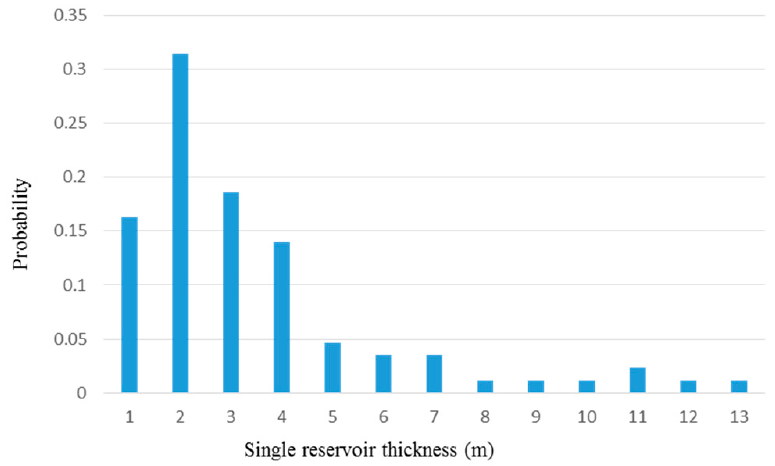
Figure 8. Statistic of single reservoir thickness of Г 1–2 ,